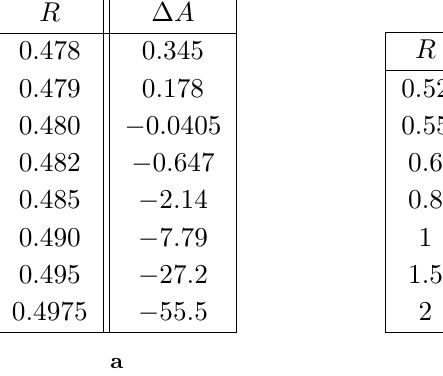
The behavior for small and large R is consistent with the discussion in section 3, but compared to the AdS 4 example we do not have a maximum in between. The remaining expansion coefficients in (4.5) can be read off from (4.4) for the cap surfaces. For the bridge surfaces the finite part is modified, as shown in figure 7 and table